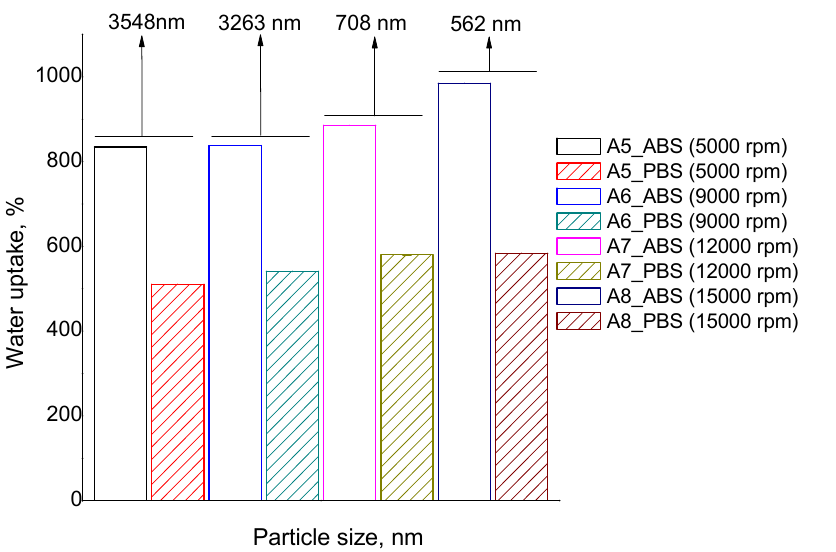
Figure 8. The influence of CPH size on the swelling process for CPH: A5 (5000 rpm); A6 (9000 rpm); A7 (12,000 rpm); A8 (15,000 rpm).